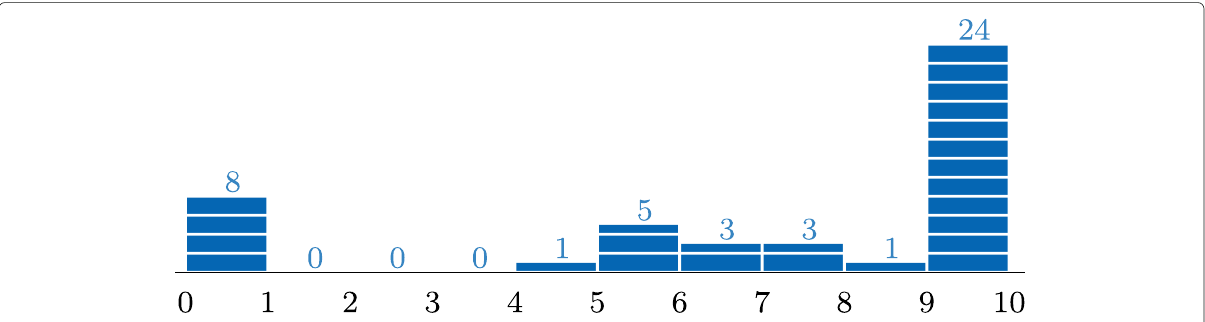
Fig. 2 Self-assessment: 8 students awarded themselves n ∈ [0,1] marks, 0 students awarded themselves n ∈ ( 1,2], etc